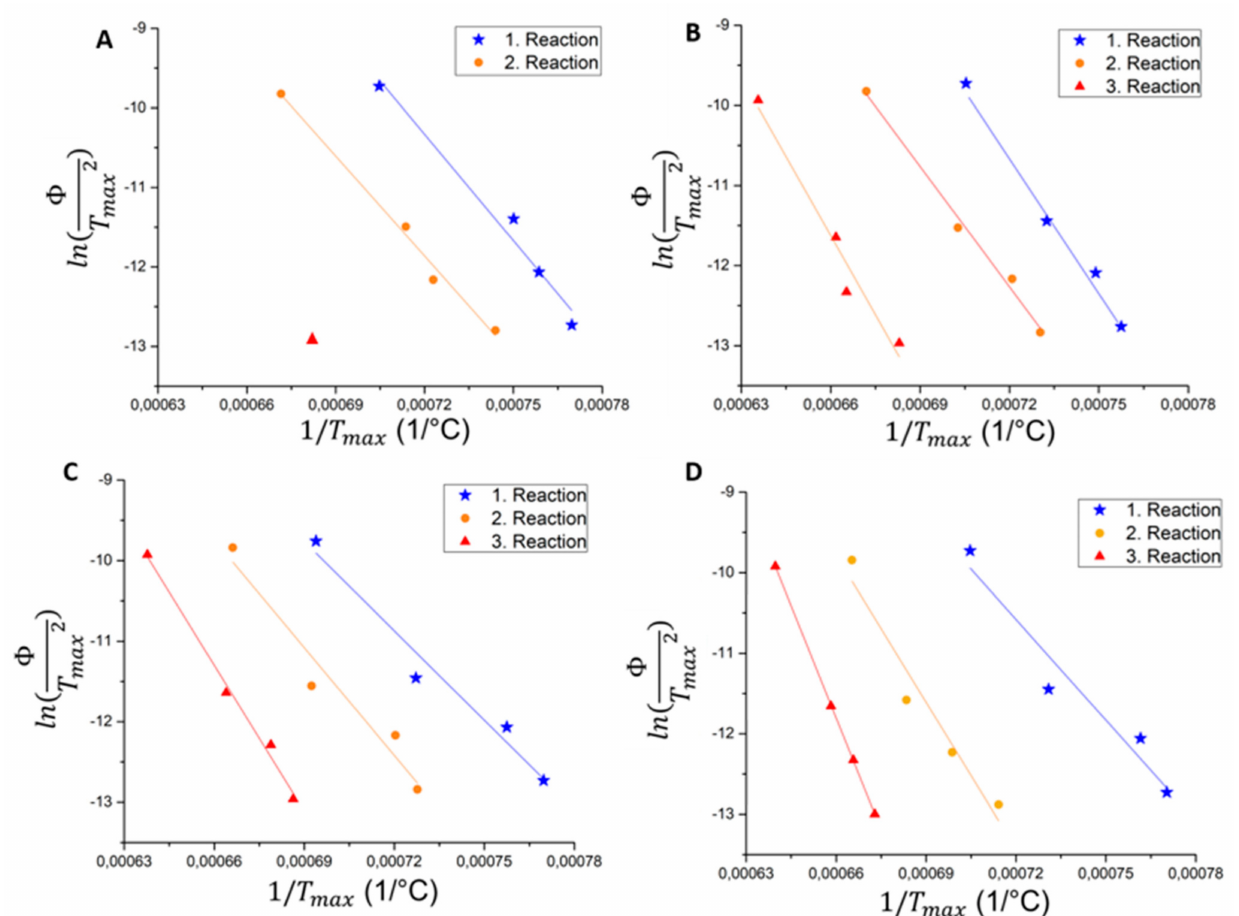
Figure 6. Kissinger plots for different melting reactions of the MA. (A) ASC + 4%CrMA1_0.6C nom (0.6C comb ), (B) ASC + 4%CrMA1_0.75C (0.72C), (C) ASC + 4%CrMA2_0.6C (0.59C), (D) ASC + 4%CrMA2_0.75C